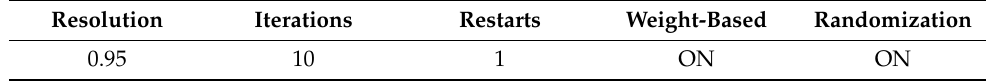
Table 2. Settings of the Louvain clustering algorithm.